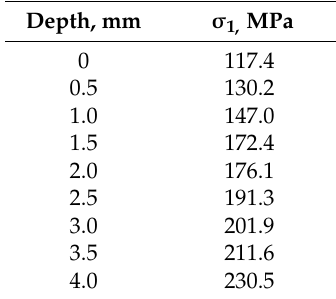
Table 9. Principal stresses in the pipe with a gouge defect of various